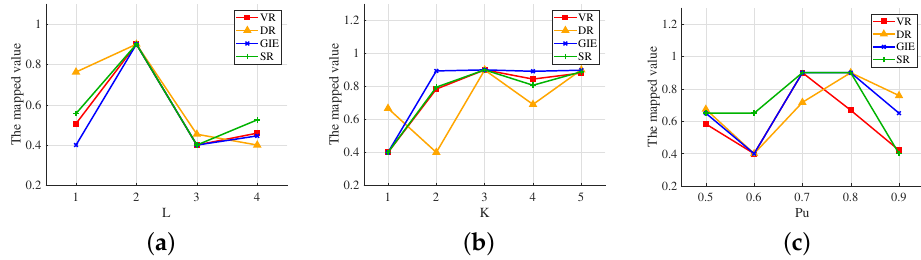
Figure 5. Evaluation results with different hyperparameters. ( a ) Results with different L . ( b ) Results with different K . ( c ) Results with different P u